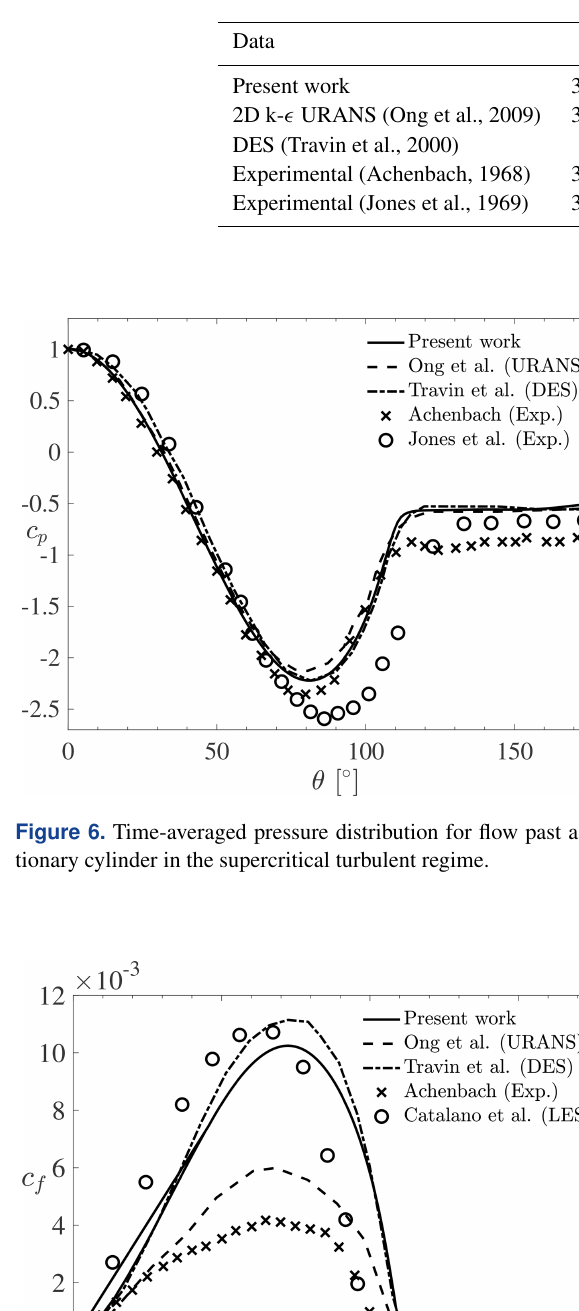
Table 2. Comparison of data for flow past a stationary cylinder in the supercritical regime. The values marked with ∗ have been estimated indirectly based on the available pressure distribution where the constant pressure plateau was reached.